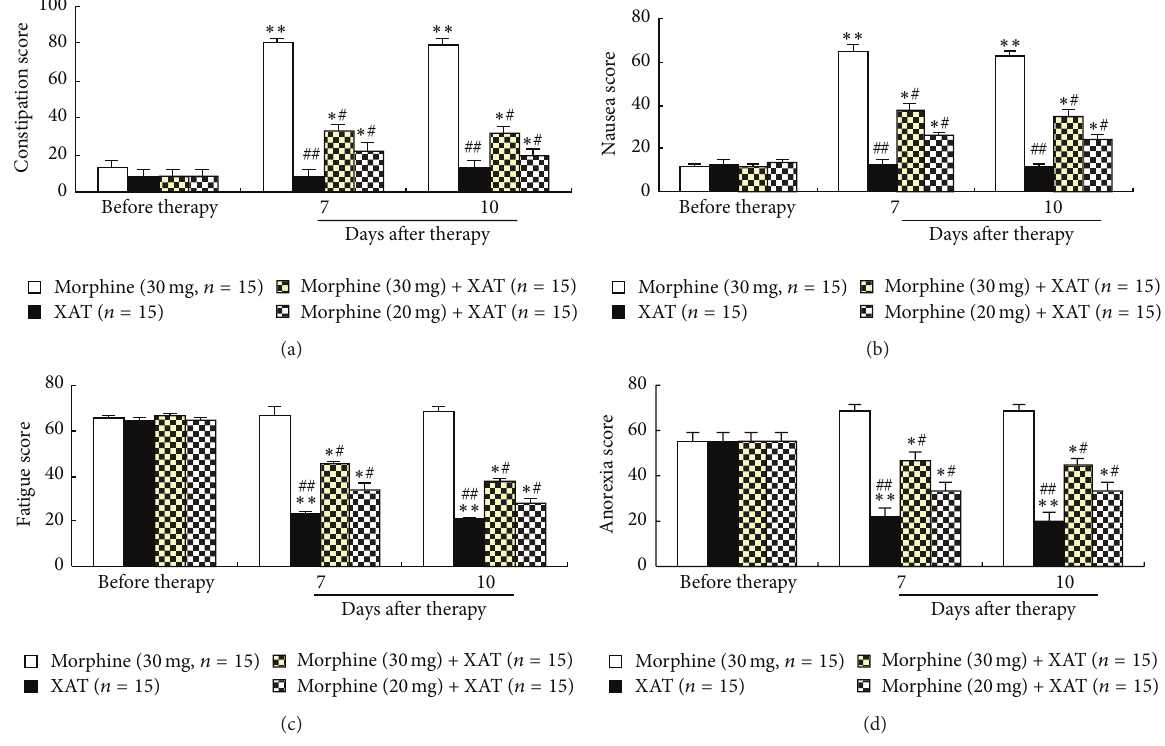
Figure 2: Effects of repetitive oral administration of XAT on the adverse reactions accompanied with cancer pain and/or morphinetreatment. The Quality of Life Questionnaire (EORTC QLQ-C30) was used to score the adverse reactions. The higher the score, the worse the adverse reaction. These adverse reactions included constipation (a), nausea (b), fatigue (c), and anorexia (d). Comparisons were made among groups of morphine, XAT, and combination of XAT and morphine at two different doses. Data are expressed as mean ± SEM. Number of patients in each group is indicated in the parentheses and all of the patients indicated in (a–d) were the same patients included in Figure 1(a) and they received the same treatments in the same protocols in the corresponding groups. The evaluation was made on day 7 and day 10, that is, 1 and 4 days after termination of the last treatment. One-way ANOVA. ∗ 𝑃 < 0.05 and ∗∗ 𝑃 < 0.01 versus the same group before therapy. # 𝑃 < 0.05 and ## 𝑃 < 0.01 versus morphine after therapy in the corresponding